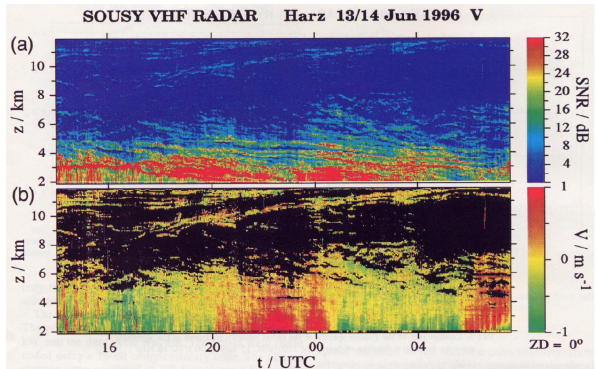
Fig. 5. (Top) Time-height cross sections of vertical SNR measured with the 53.5 MHz Sousy radar at a 0.5 µ s pulse duration (75-m range resolution) and time resolution of 33 s and (bottom) the cor- responding radial velocities measured with the vertically pointing beam. The most striking feature is the large number of thin and long-lived echoing layers. Some of them can be thinner than the 75-m range resolution used (after R¨uster et al.,